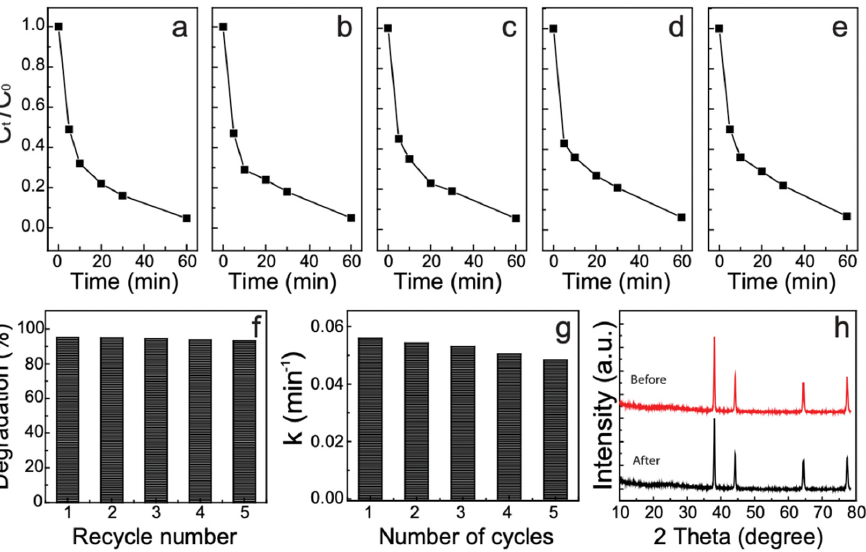
Figure 8. ( a – e ) Recycling efficiency of MB in the presence of the AgNP–CNS nanocomposite; ( f ) dye removal percentage, and ( g ) rate constants after five repeated cycles, and ( h ) XRD plots of the AgNP–CNS nanocomposite before and after the reusability test.